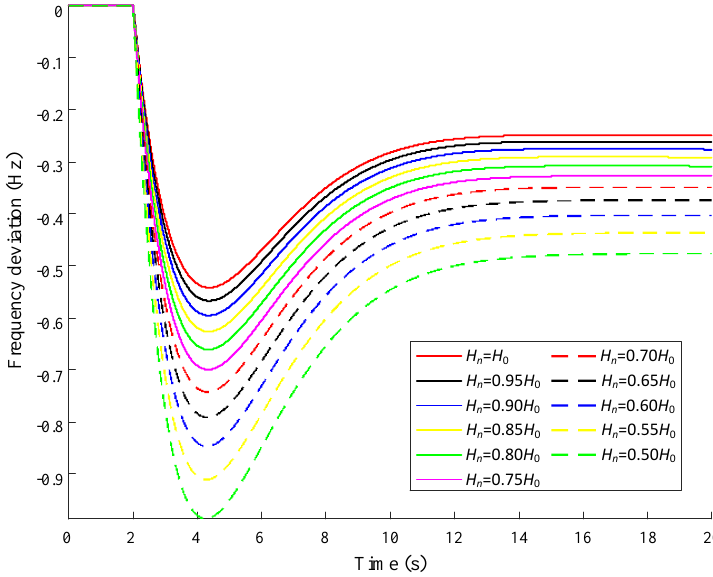
Figure 4. Frequency dynamic response with different equivalent inertia H.